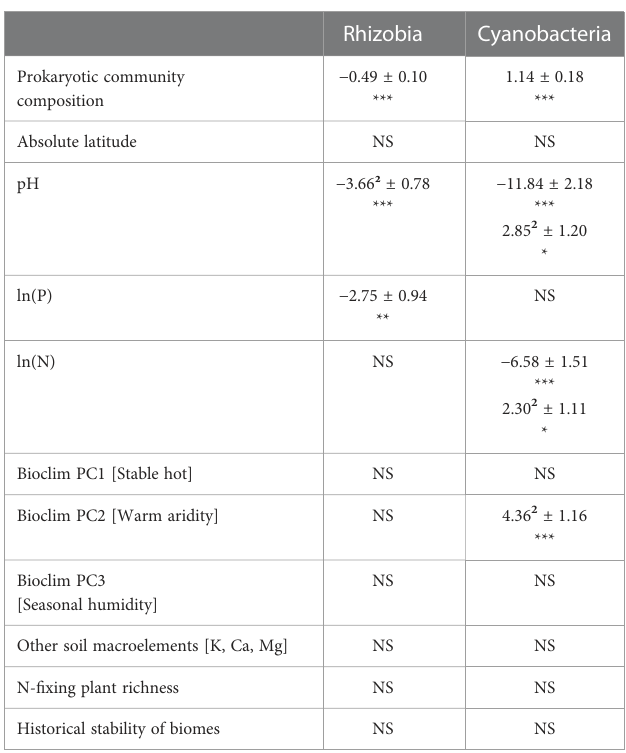
TABLE 2 Factors affecting the relative abundance [ln(group/(all prokaryotes – group))] of rhizobia and Cyanobacteria.